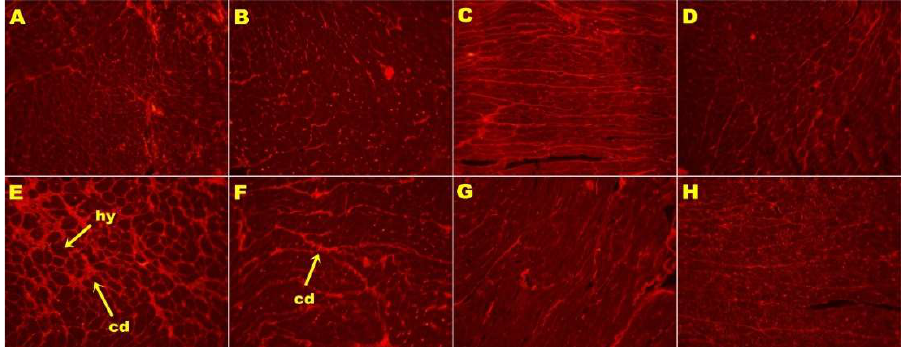
Figure 3. Picrosirius red staining of left ventricular interstitial collagen deposition (magnification ×20; shown by arrows) in rats fed corn starch diet-fed rats ( A ), corn starch diet-fed rats treated with whole linseed ( B ), corn starch diet-fed rats treated with defatted linseed ( C ), corn starch diet-fed rats treated with SDG ( D ), high-carbohydrate, high-fat diet-fed rats ( E ), high-carbohydrate, high-fat diet-fed rats treated with whole linseed ( F ), high-carbohydrate, high-fat diet-fed rats treated with defatted linseed ( G ), and high-carbohydrate, high-fat diet-fed rats treated with SDG ( H ). Collagen deposition is marked as “cd” and hypertrophied cardiomyocytes are marked as “hy”.